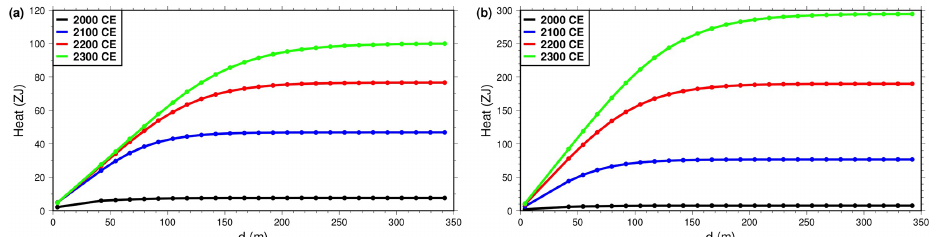
Figure 7. Heat stored in the subsurface as function of subsurface thickness for the years 2000 (black), 2100 (blue), 2200 (red) and 2300 (green). (a) Simulations forced with CRUNCEP+RCP4.5 data. (b) Simulations forced with CRUNCEP+RCP8.5 data. Note the vertical scale difference between the two panels.